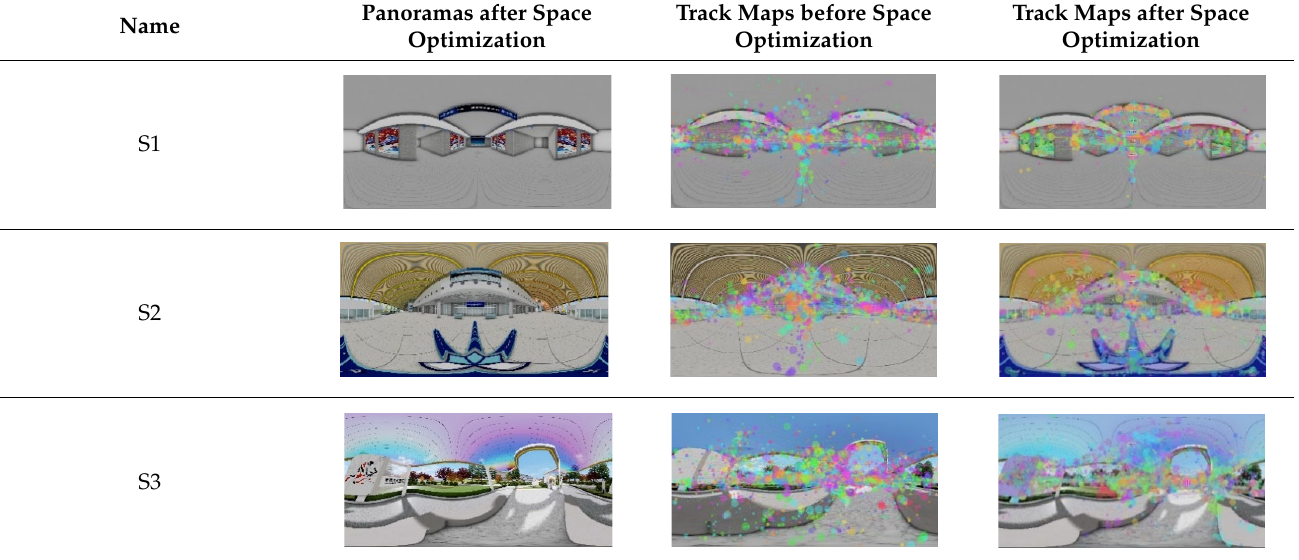
Table 10. Comparison of Track Maps before and after Optimization.